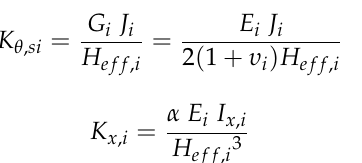
For each wall or column ‘ i ’ with uniform cross-section about its height, the torsional stiffness due to shear ( K θ ,si ) can be determined from shear modulus ( G ), torsion constant ( J ) and effective height ( H eff ) as shown in Equation (3). Similarly, the translational stiffness ( K i ) for y-direction of motion can be determined from Equation (4) based on Young’s modulus ( E ), second moment of area ( I ), effective height ( H eff ), and stiffness factor ‘ α ’ (equal to 3 for cantilever wall and 12 for columns restrained by building floors). In Equation (3), the shear modulus ( G ) is interchanged with ‘ E /2(1 + ν )’. ‘ ν ’ is the Poisson’s ratio.